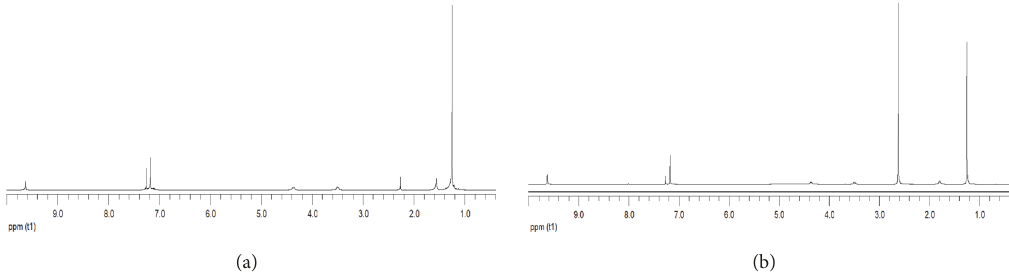
Figure 10: 1 H NMR spectra of (a) H 8 L at 25 ∘ C in CDCl 3 and (b) Cd-H8L at 25 ∘ C in CDCl 3 at 400